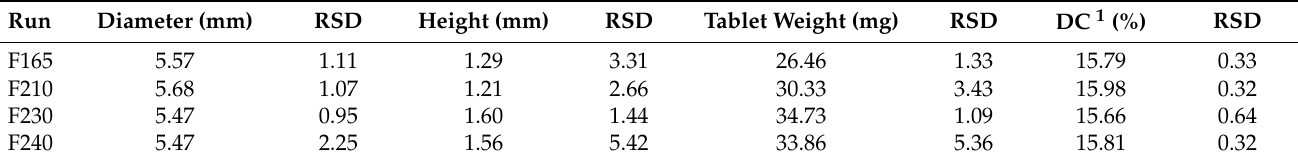
Figure 5. TGA thermograms of as-received GF, KP and HPC powders along with 3D printed tablet (F240). Table 4. Post-printing dimensions and drug content uniformity of the FDM 3D printed tablets.